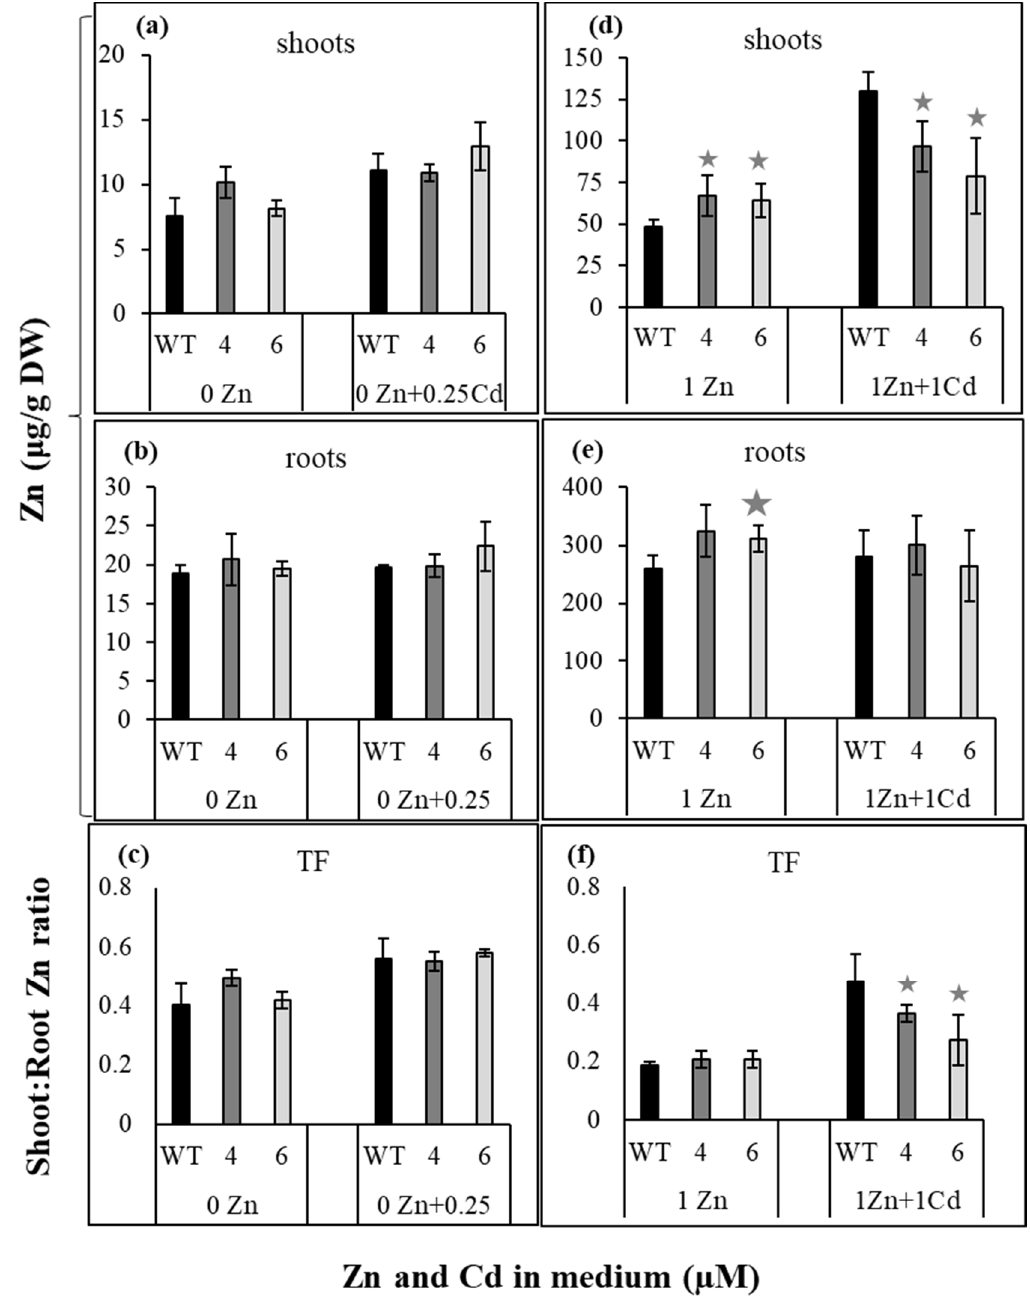
Figure 1. Zinc concentration in wild-type and NtZIP4A / B -RNAi plants, grown under various Zn and Cd concentrations. 3.5-week-old plants of wild-type (WT) and NtZIP4A / B -RNAi lines (number 4 and number 6) grown in the quarter-strength Knop’s medium were exposed for 17 days to the control medium supplemented with pairwise combinations of Zn (0; 1 μ M) and Cd (0; 0.25; 1 μ M) concentrations. Concentrations of zinc were determined in the shoots ( a , d ) and roots ( b , e ). The Translocation Factor (TF) was determined as the ratio of shoot/root concentrations of Zn ( c , f ). Values correspond to means ±SD ( n = 5); those significantly different from wild-type (WT) (evaluated by Student’s t -test) are indicated by asterisks ( p ≤ 0.05).